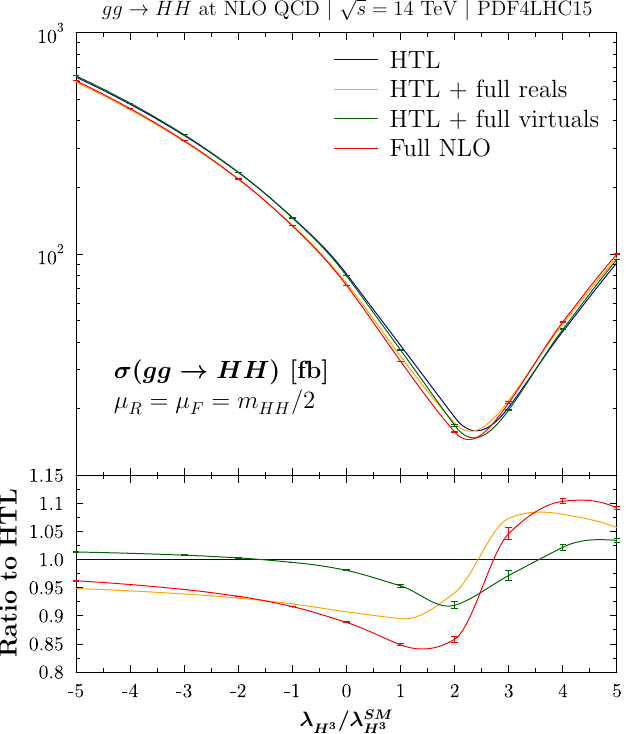
Figure 16 . The total Higgs-pair production cross section at NLO as a function of the trilinear self-coupling (cid:21) H 3 in units of the SM value for a c.m. energy of 14 TeV. The blue curve shows the Born-improved HTL, the yellow includes the NLO mass e(cid:11)ects of the real corrections in addition and the green curve those of the virtual corrections in addition. The full NLO result is presented by the red curve. The lower panel shows the ratio of all results to the Born-improved HTL. PDF4LHC PDFs have been used and the renormalization and factorization scales of (cid:11) s and the PDFs have been (cid:12)xed at our central scale choice (cid:22) R = (cid:22) F = Q= 2 = m HH = 2.